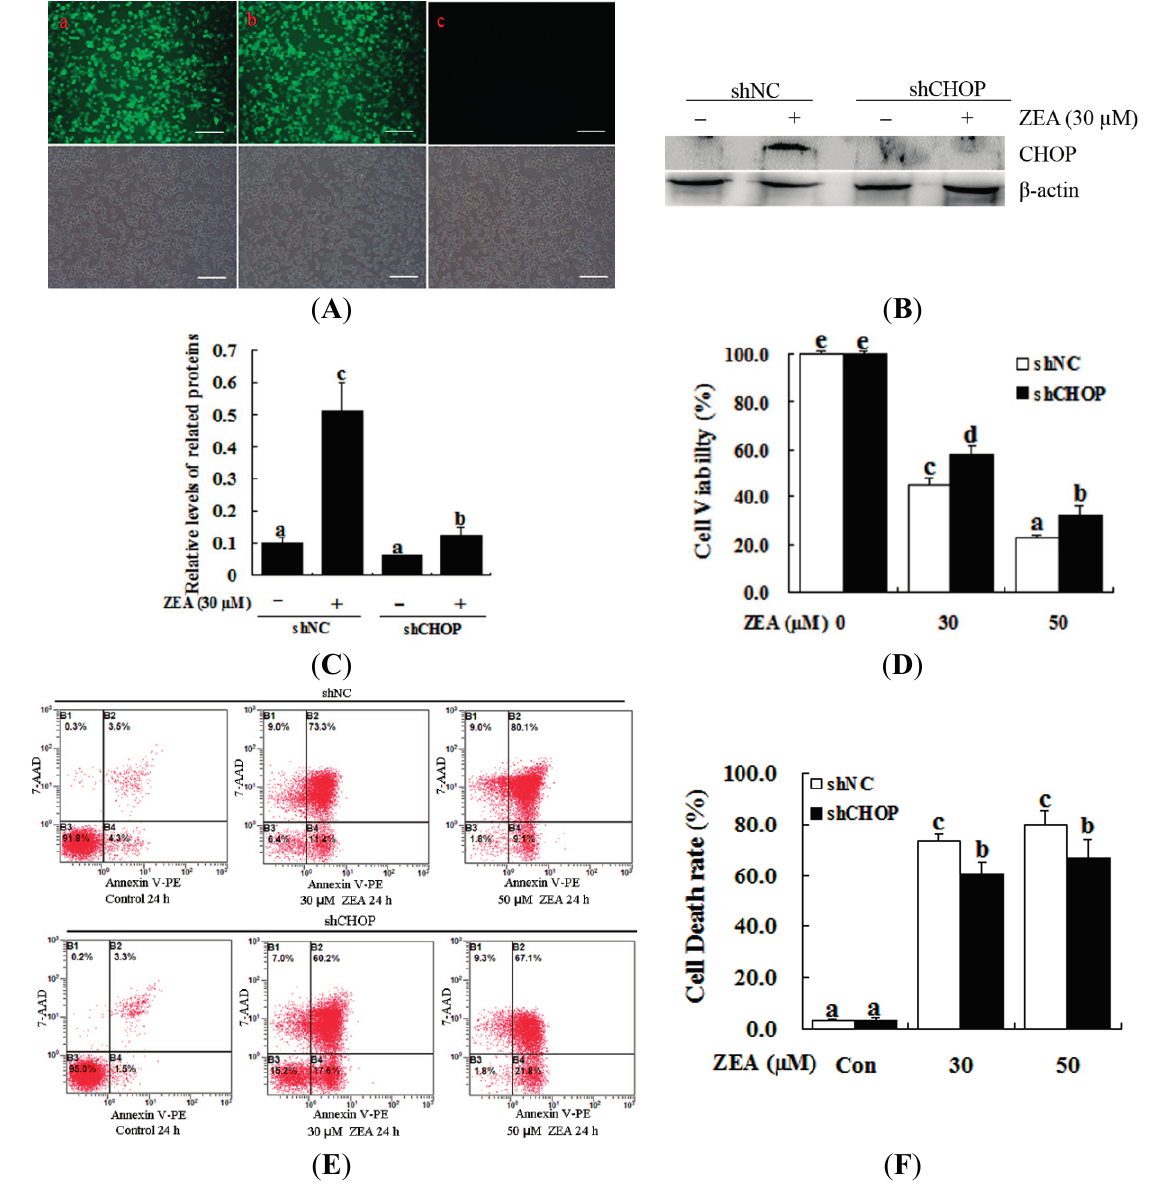
Figure 5. Effect of CHOP on the ZEA-induced cell death of RAW 264.7 macrophages. RAW 264.7 macrophages were transduced with CHOP or non-targeting lentiviral-mediated shRNAs. ( A ) The constructs themselves could express GFP, and the proportion of cells that were transduced was 90% by fl ow cytometry (data not shown). Fluorescence images of RAW 264.7 macrophages transducted for 48 h with negative control shRNA (shNC) ( a ), shCHOP ( b ) and control ( c ) virus-containing supernatant; GFP expression was observed under light ( top panels) or fluorescence microscopy ( bottom panels). Bars = 50 µm; ( B , C ) The expression